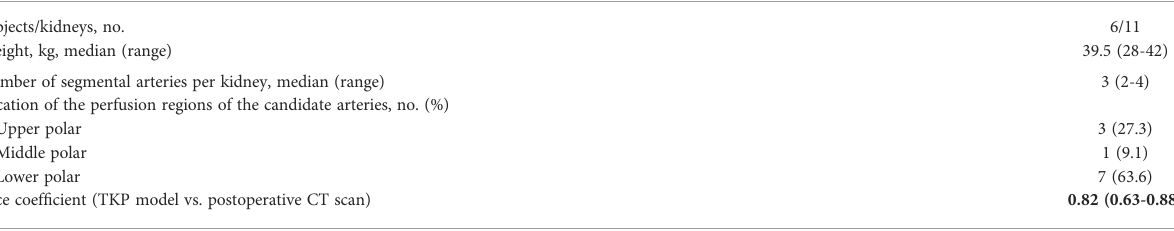
6/11 39.5 (28-42)